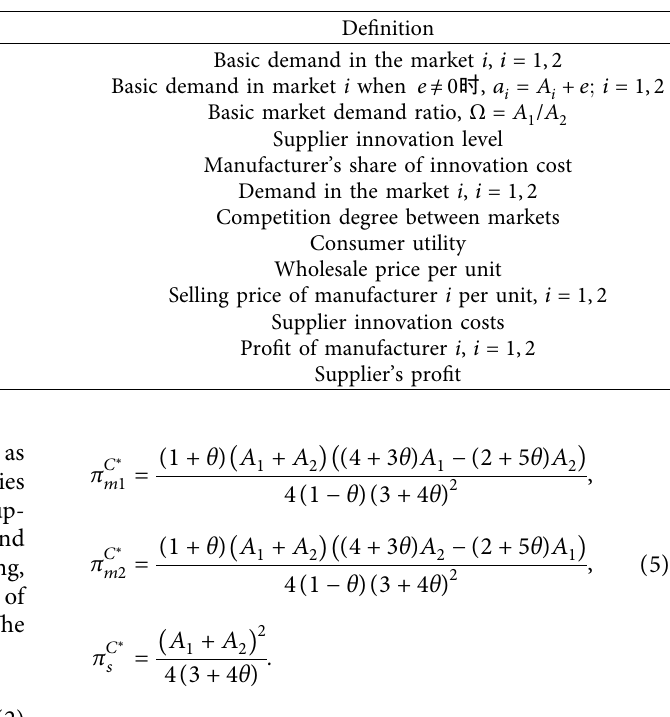
Table 1: Definitions of model